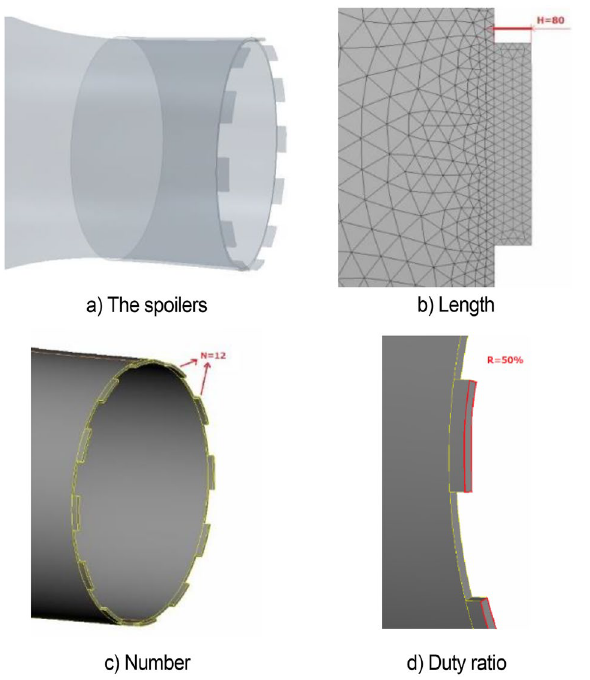
Figure 23. The spoiler model and geometric